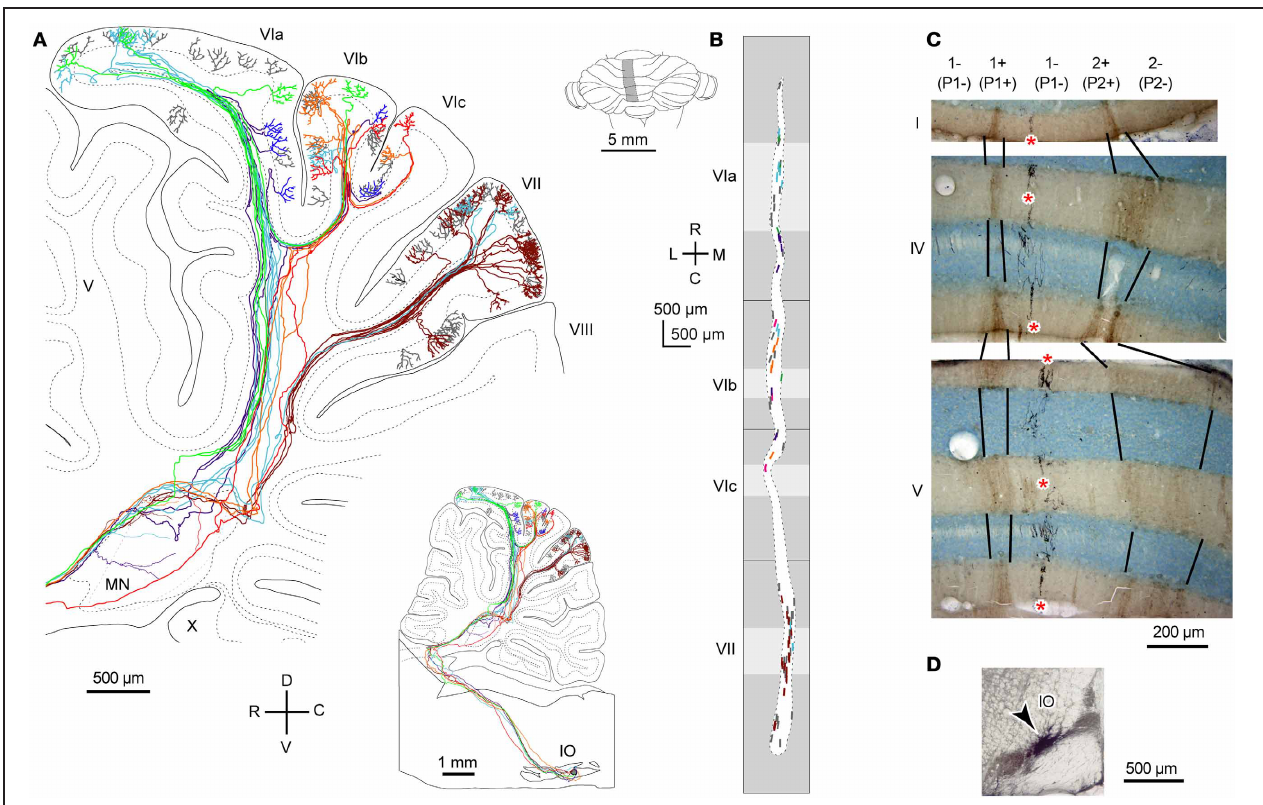
localized injection of biotinylated dextran amine to the IO were distributed in a narrow band-shaped area that occupied a portion of a single aldolase C compartment. (D) Injection site of biotinylated dextran amine in the rat IO. (A) and (B) are cited from Sugihara et al. (2001). (C) and (D) are based on the data in Sugihara et al. (2004). 1 + , 1 − , 2 + , names of aldolase C compartments according to the nomenclature of Sugihara and Shinoda (2004), which are equivalent to “P1 + ,” “P1 − ,” and “P2 + ” as often used in ligature (Brochu et al., 1990; Apps and Hawkes,